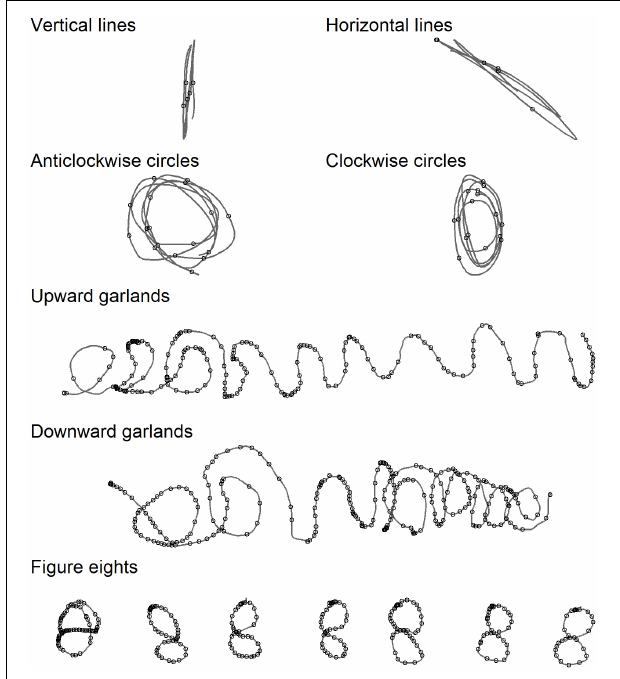
FIGURE 3 | Example output from the various pen-control tasks, produced by the same child as in Figure 2 . Small circles represent the location in the pen trace of a velocity peak, after 10 Hz